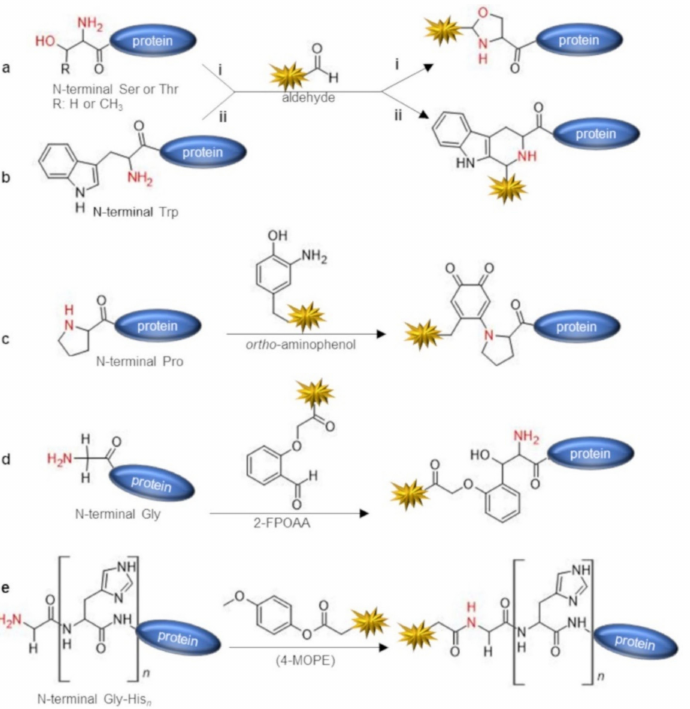
Figure 3. Site-specific protein labeling through the targeting of N-terminal Ser (or Thr) ( a ), Trp ( b ), Pro ( c ), Gly ( d ), or Gly-His n ( e